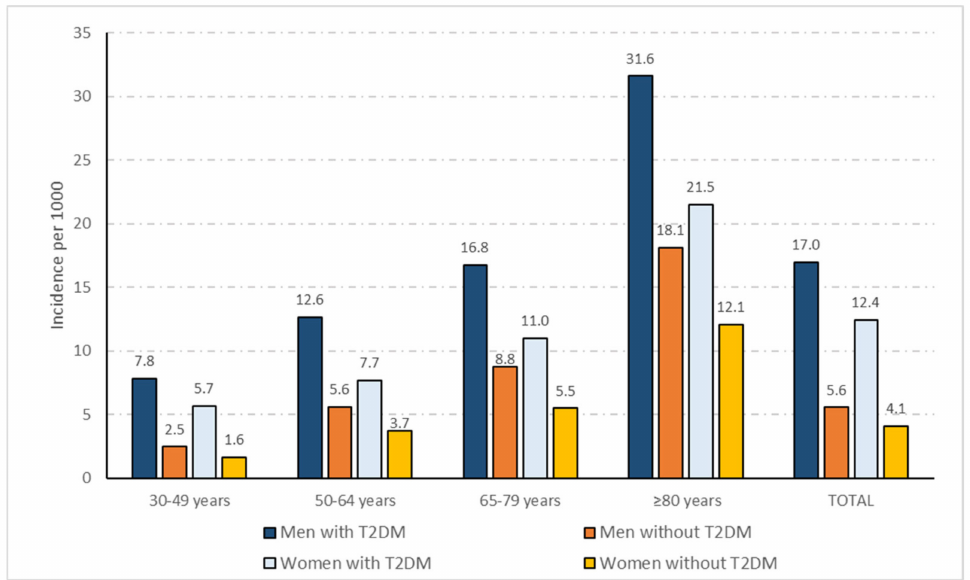
Figure 1. Incidence rates of hospital admission with COVID-19 per 1000 inhabitants with and without T2DM according to sex and age